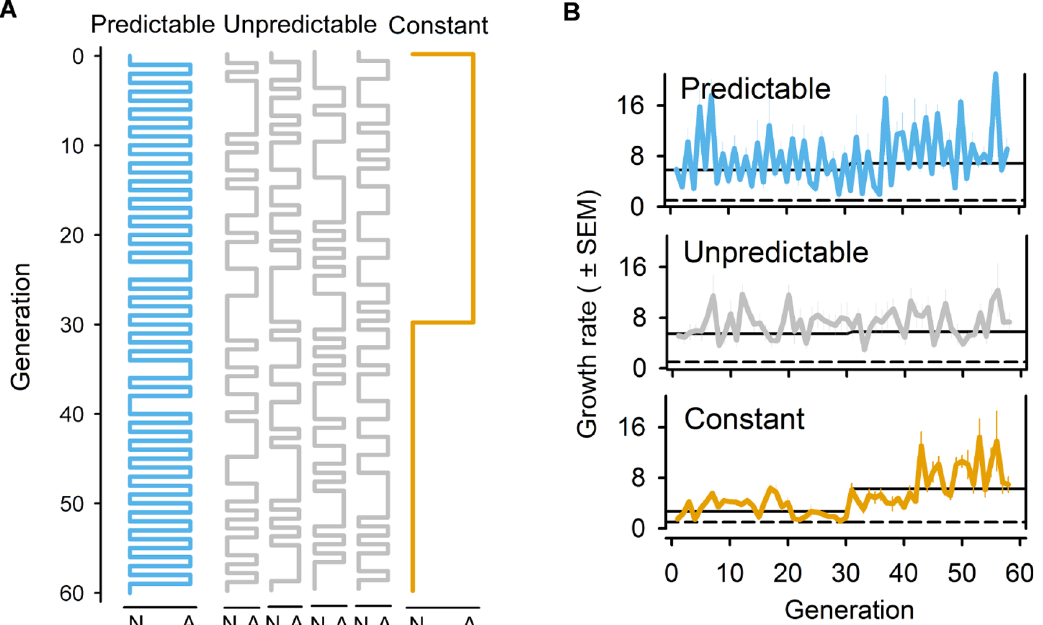
Fig 3. Experimental evolution under fluctuating normoxia – anoxia environments. (A) Schematic of the fluctuating sequences of normoxia (N) and anoxia (A) environments employed during the 60 generations of experimental evolution. See S2 Fig for the autocorrelation and spectral decomposition of environmental fluctuations at several intervals [65,66]. (B) Mean expected growth rates during experimental evolution, measured from generation 1 to generation 58. Error bars show one standard error of the mean among replicate populations. Solid lines show the geometric mean growth rate for the first 30 generations or the last 30 generations of experimental evolution. Dashed lines show the growth rate below which the population would go extinct, under the fixed density conditions of the life cycle. Environmental sequences and data deposited in the Dryad repository: http://dx.doi.org/10.5061/dryad.56bb4 [59].